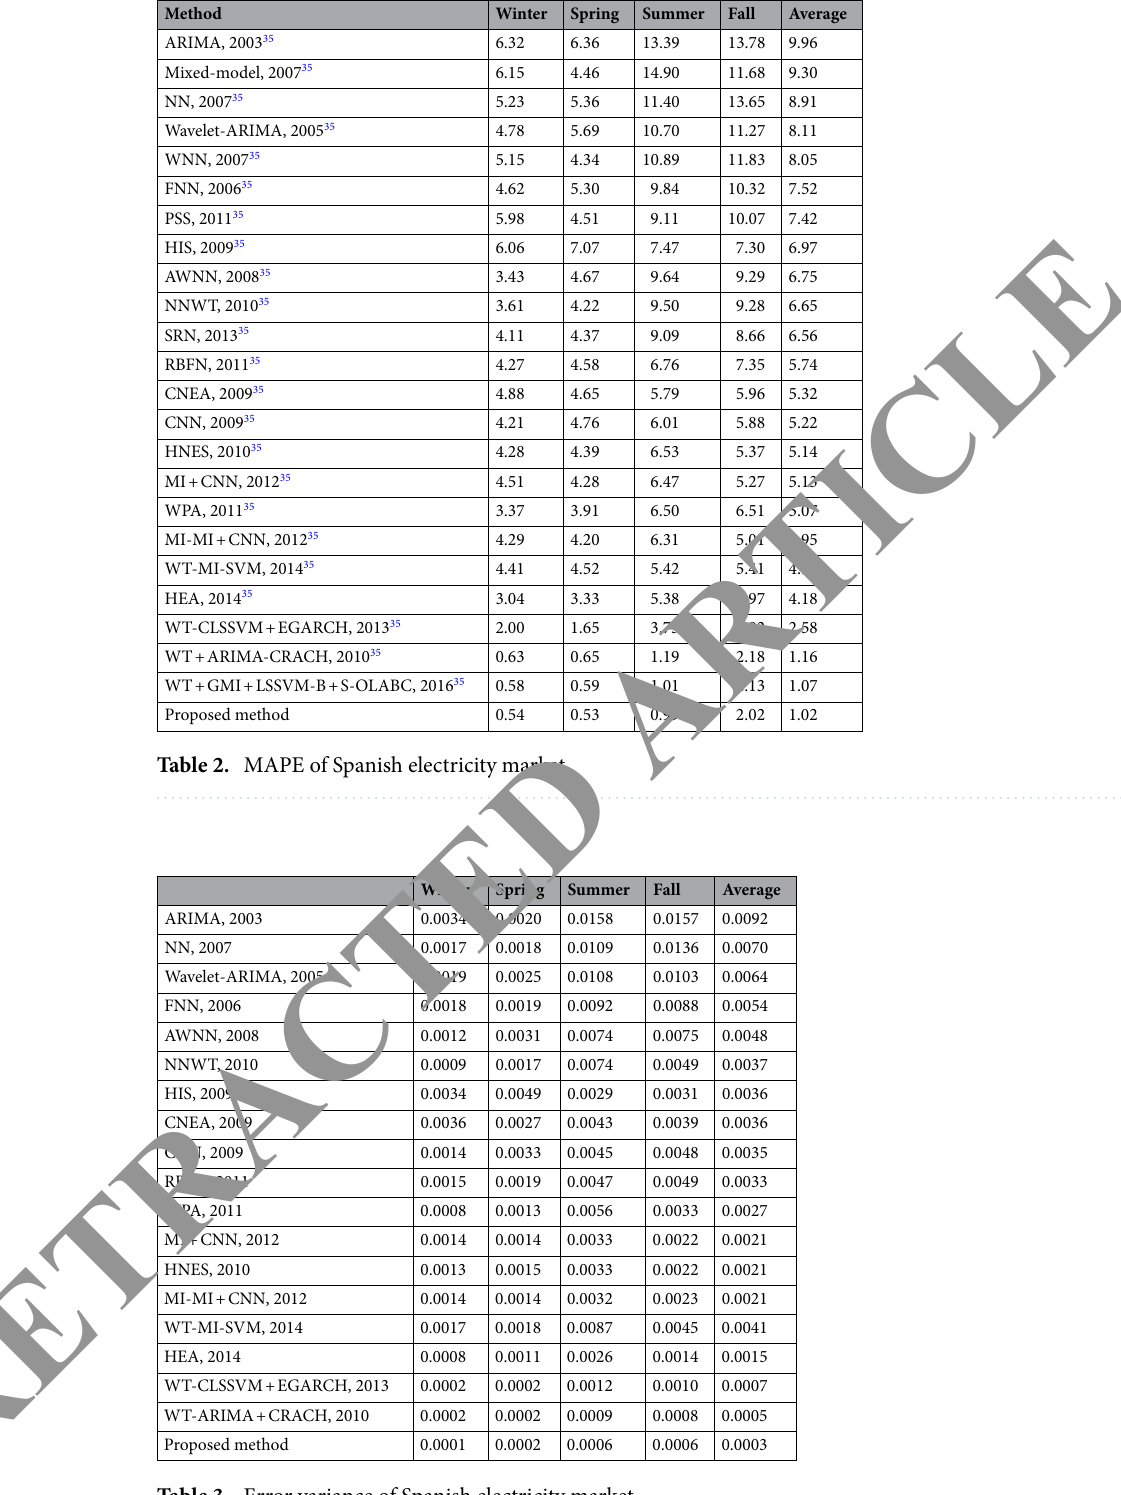
Table 3. Error variance of Spanish electricity